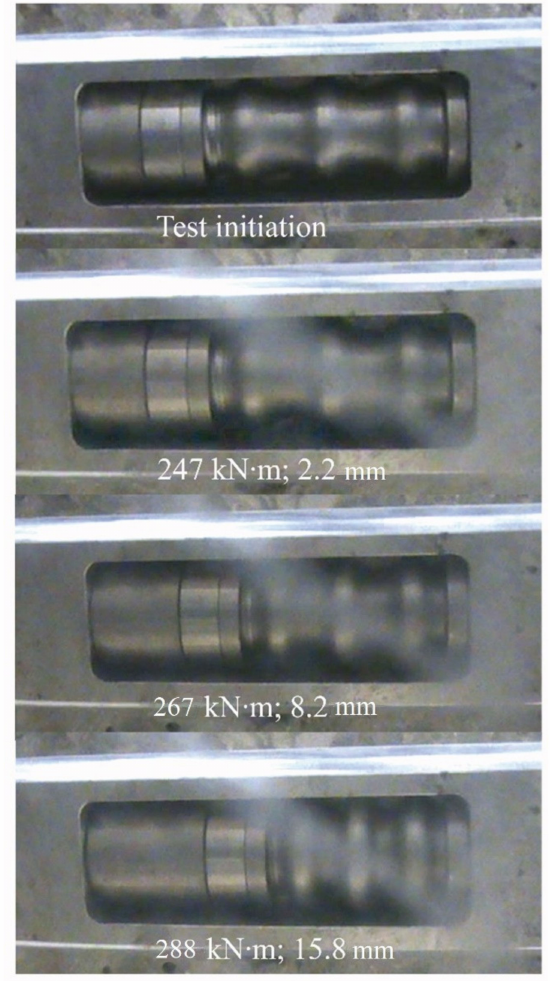
Figure 12. Deformation magnitudes during test of beam PU1-2.